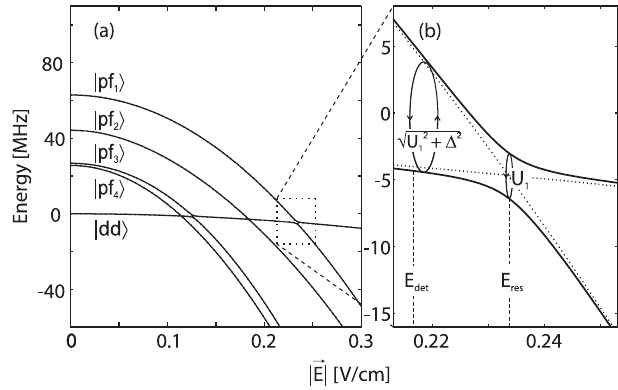
indicated.FIG. 1. (a) Schematic of the pair-state interferometer. Interactions between Rydberg atoms change the phase ’ ð U Þ of the j rr i state relative to the other states and create population in j r 0 r 00 i . A pulsed Ramsey field couples three states simulta- neously. A Rydberg detector detects the number of Rydberg atoms N Ryd , resulting in (b) a Ramsey spectrum (blue data points) depending on the combined detuning (cid:1) of the two- photon excitation. The red line is a fit to the data. (c) The transfer function for 0 : 6 (cid:2) -Ramsey pulses describing the depen- dence of the fitted phase of the Ramsey fringes (cid:1) on the phase shift ’ in the j rr i path for small